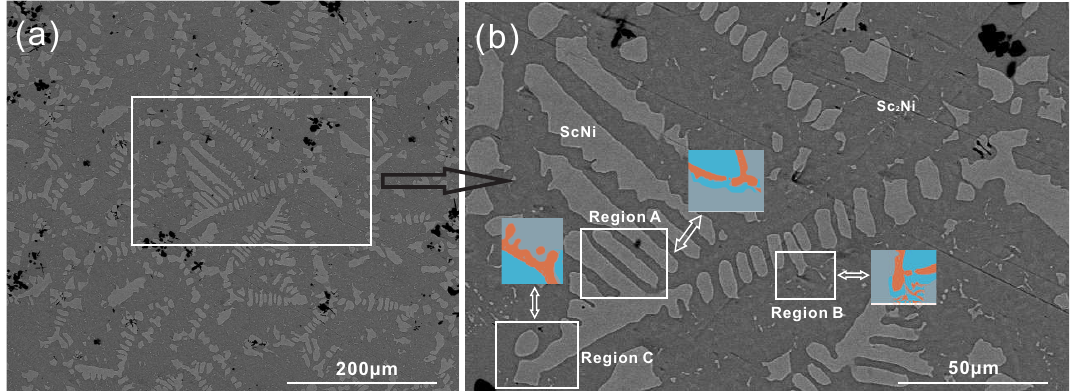
Figure 1. ( a ) Experimental microstructure of as-cast Sc-34 at % Ni binary alloy; ( b ) Enlarged view of the rectangular section in ( a